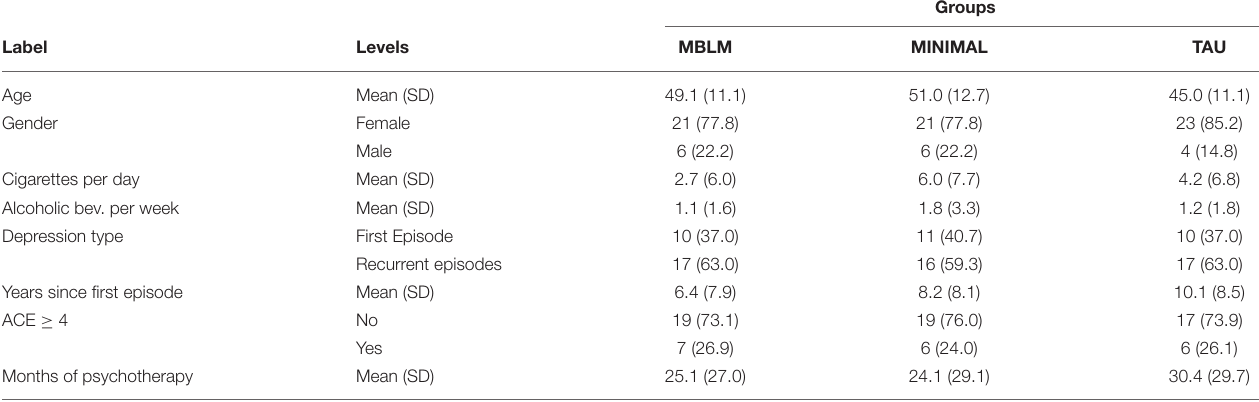
TABLE 1 | Participant